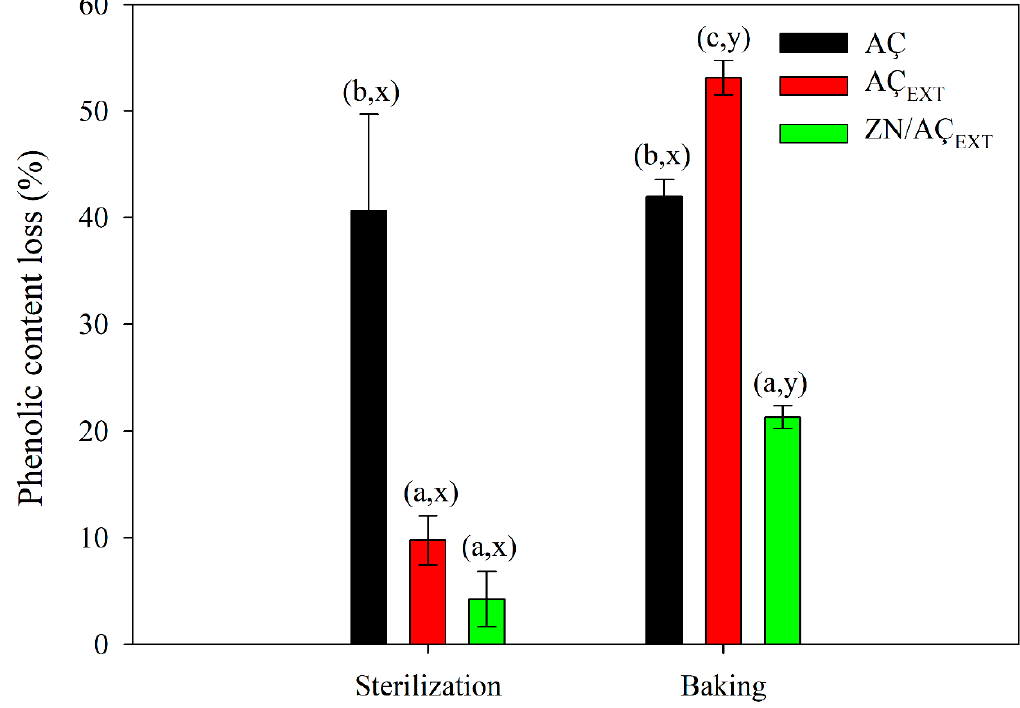
Figure 4. Loss of polyphenolic content (%) of the samples when subjected to thermal treatments. Values a, b, and c indicate significant differences between samples for the same thermal treatment. On the other hand, x and y indicate significant differences between thermal treatments for the same sample, determined through a one-way analysis of variance (ANOVA) ( p < 0.05).